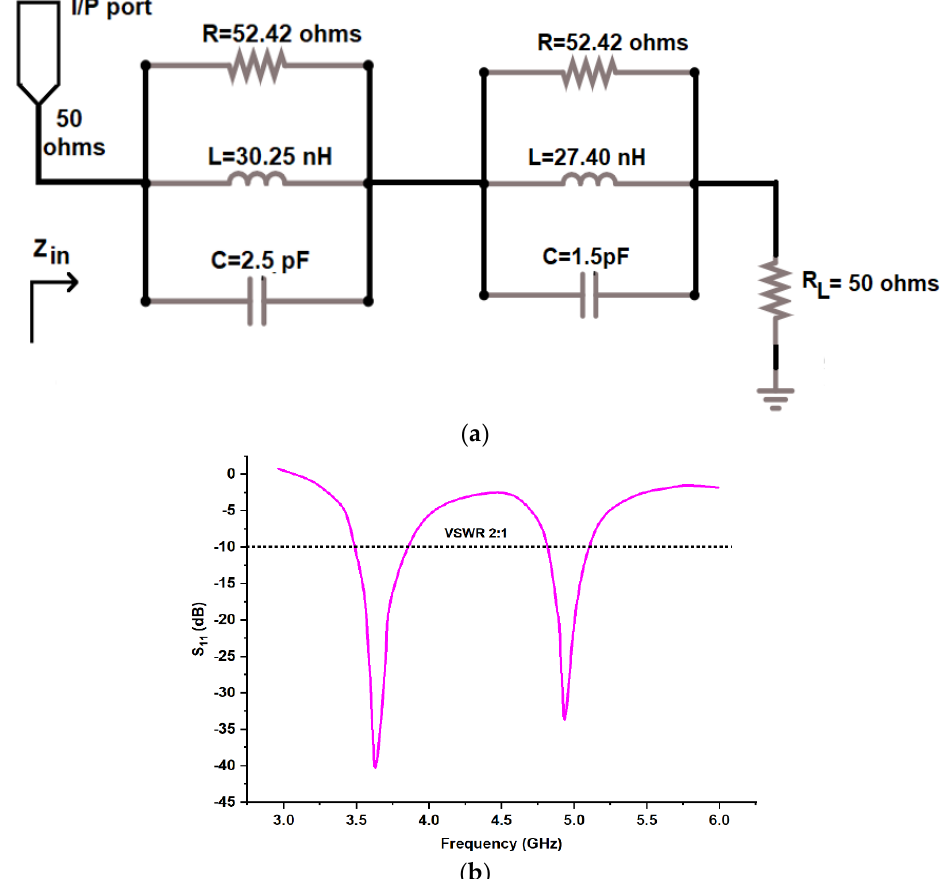
Figure 5. ( a ) Schematic ECD model and ( b ) S11 (dB) of the proposed antenna.